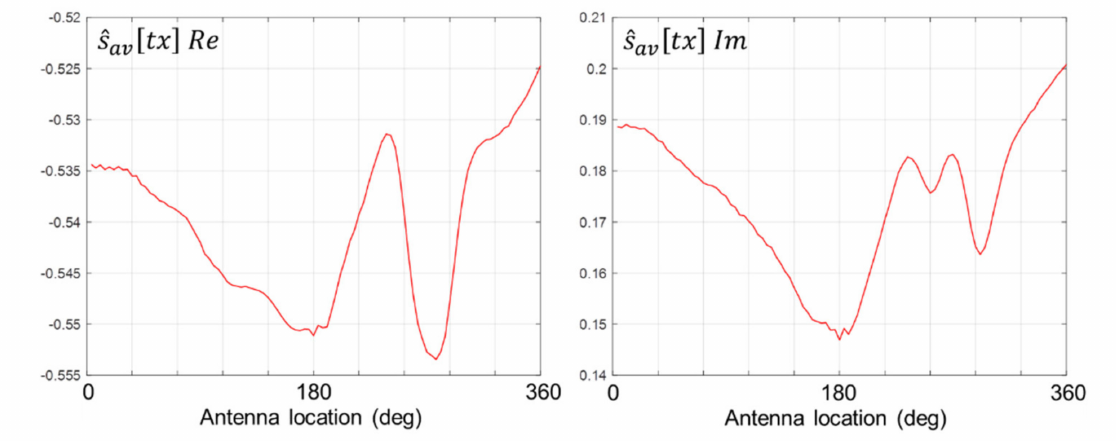
Figure 9. Real ( left ) and imaginary ( right ) values of ˆ s av [ tx ] for scan